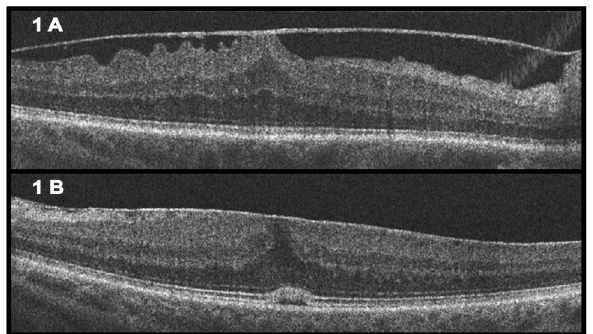
Figure 1. Optical coherence tomography of two eyes with dissimilar characteristics of the epiretinal membrane (ERM): 1A shows almost complete elevation of the ERM and retinal folds in the temporal segment; 1B shows a diffusely adherent ERM to the retinal surface without elevation and minimal nasal